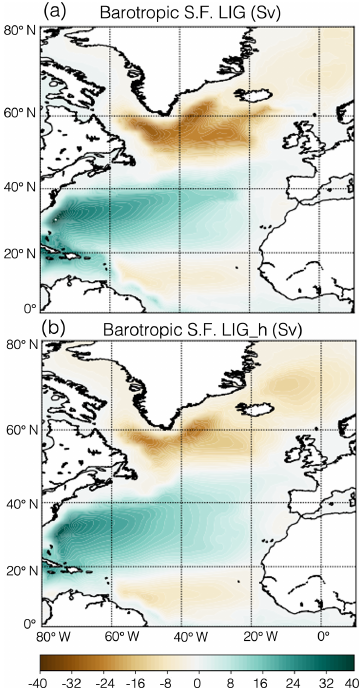
Figure 10. The annual mean barotropic streamfunction in the North Atlantic for the LIG (a) and the LIG_hosing (b)